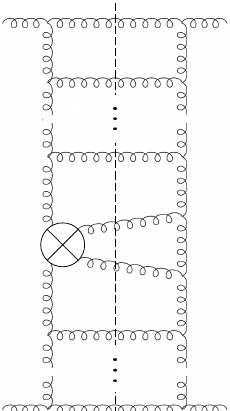
Figure 9 . A colour structure of an interference, or ‘ladder’ diagram at NNLL accuracy, containing one instance of the one-loop two-gluon CEV, and all other real emissions given by tree-level one-gluon CEVs. The ⊗ symbol represents the fully symmetric trace d of the two-gluon CEV. This colour A structure vanishes upon summing over all colour indices, as discussed in the main